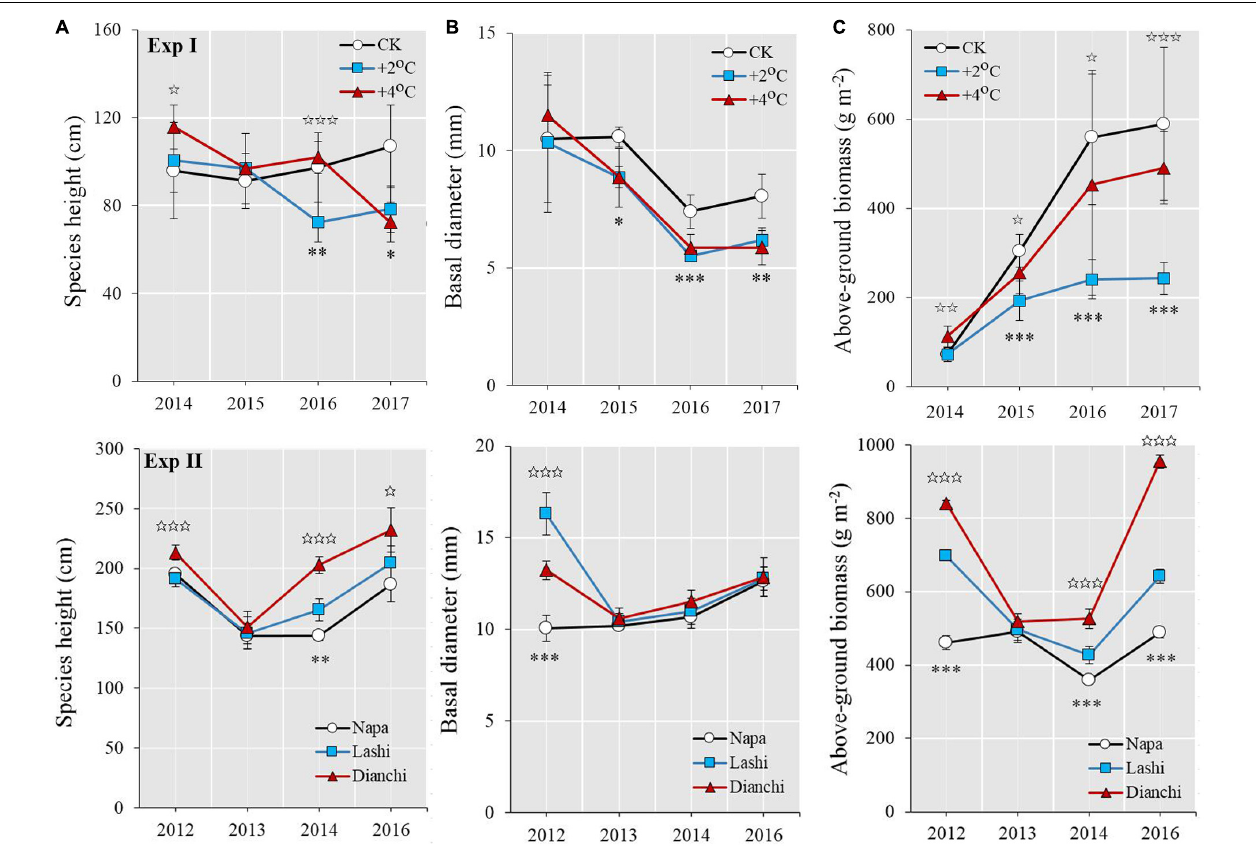
FIGURE 6 | Growth and productivity variables of S. tabernaemontani over time between treatments. (A) Species height, (B) basal diameter, and (C) above-ground biomass. For Exp I , ambient conditions (CK), 2 ◦ C-warming (+2 ◦ C) as well as 4 ◦ C-warming (+4 ◦ C) are compared using OTCs. For Exp II , Napa, Lashi, and Dianchi are compared along a latitudinal gradient. Error bars indicate standard deviations. Significant differences between CK and +2 ◦ C as well as Napa and Lashi are indicated by close asterisks ( ∗∗∗ p < 0.001; ∗∗ p < 0.01; ∗ p < 0.05). Significant differences between +2 ◦ C and +4 ◦ C as well as between Lashi and Dianchi are indicated by open asterisks ( (cid:73)(cid:73)(cid:73) p < 0.001; (cid:73)(cid:73) p < 0.01; (cid:73) p <